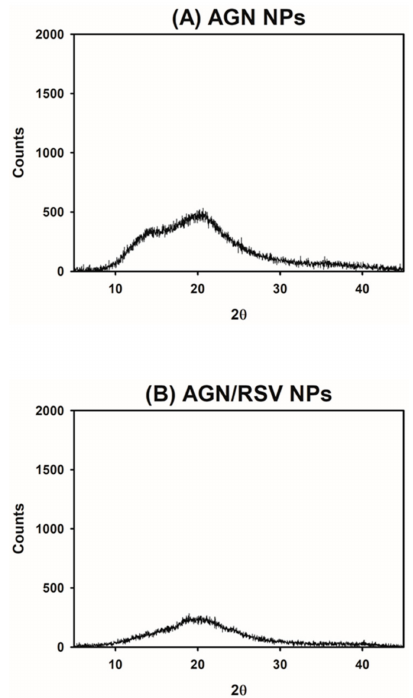
Figure 2. The XRD analysis data of NPs. Counts values of ( A ) AGN NPs and ( B ) AGN/RSV NPs, according to 2 θ , are